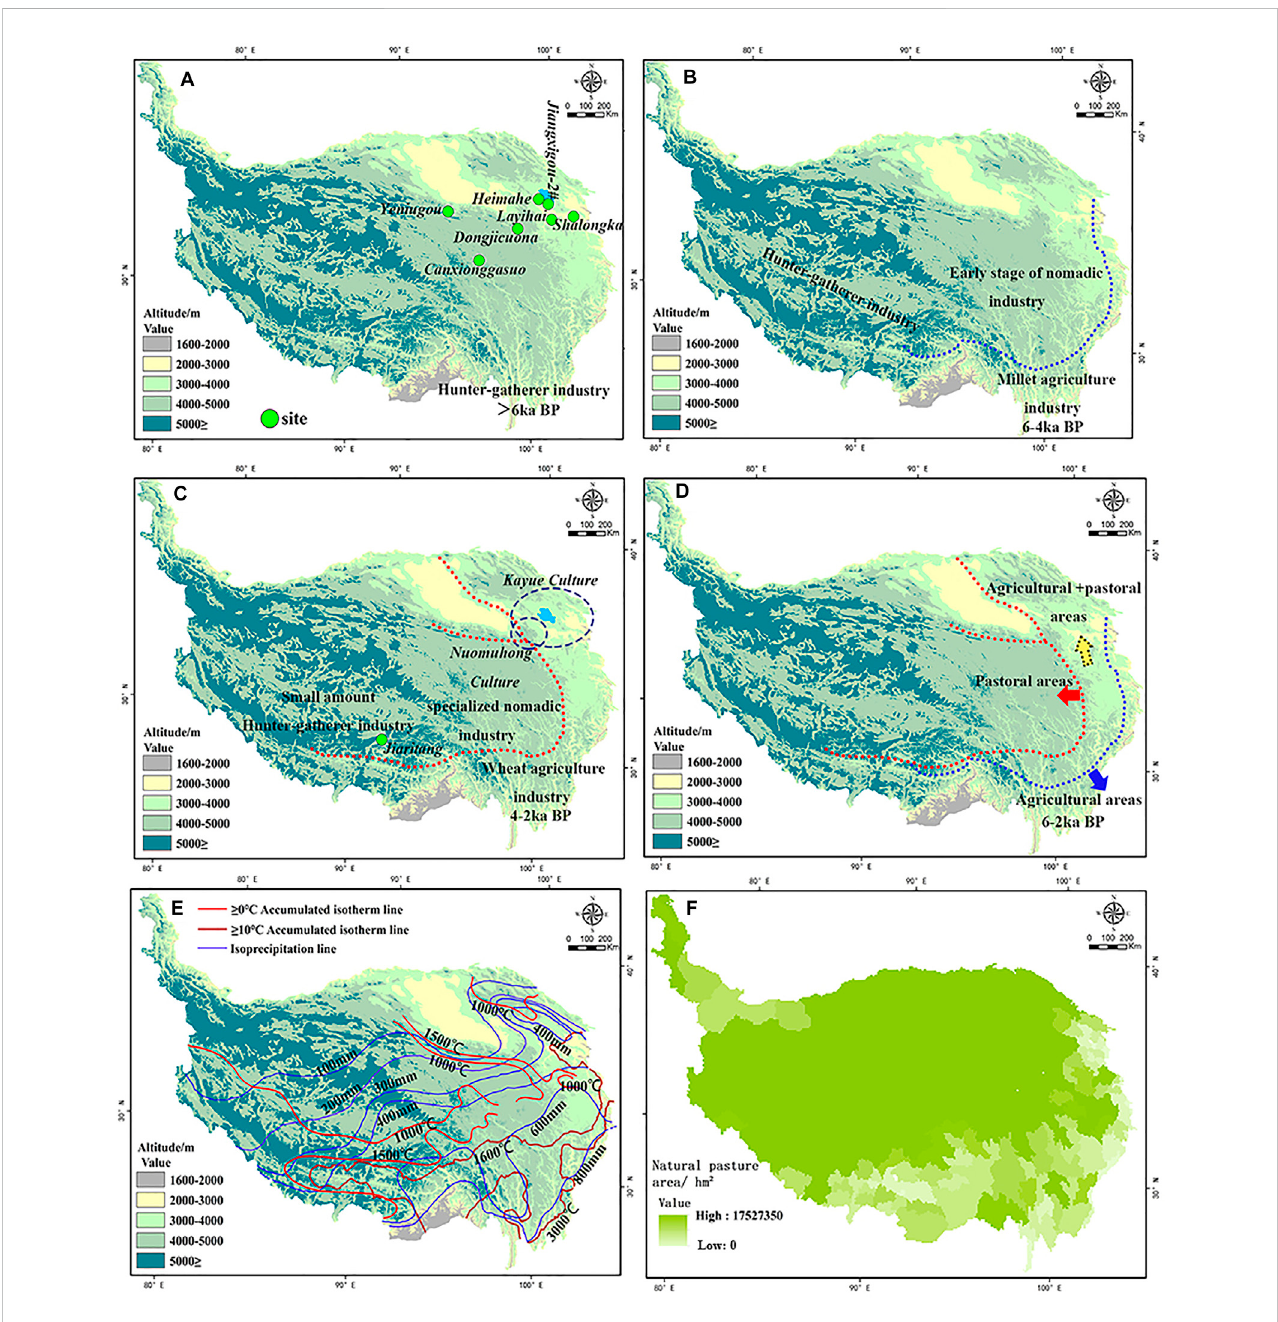
FIGURE 10 EvolutionofagriculturalandpastoralactivityontheQinghai-TibetanPlateau6 – 2ka.BP. (A) Hunter-gathererindustry, > 6ka.BP; (B) Earlystageofnomadic industry and emergence of millet agriculture, 6 – 4ka.BP; (C) Emergence of the wheat agriculture industry, 4 – 2ka.BP; (D) Trends in the location of agriculture and nomadic herding areas, 6 – 2ka.BP; (E) Temperature and precipitation trends; (F) Natural pasture area.